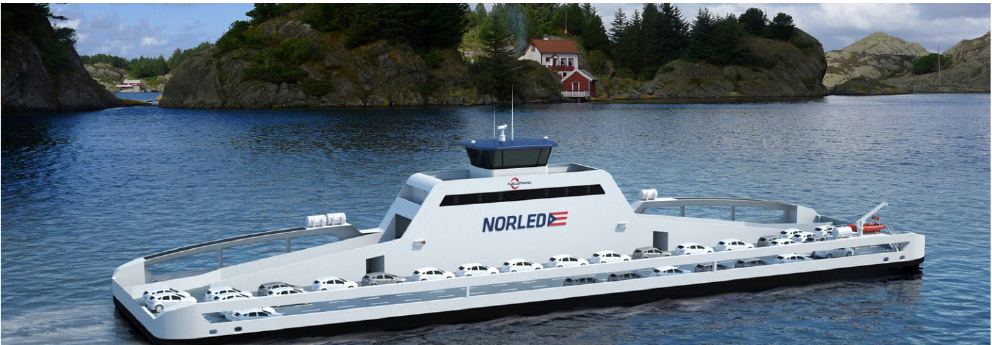
Figure 16. The Zerocat 120